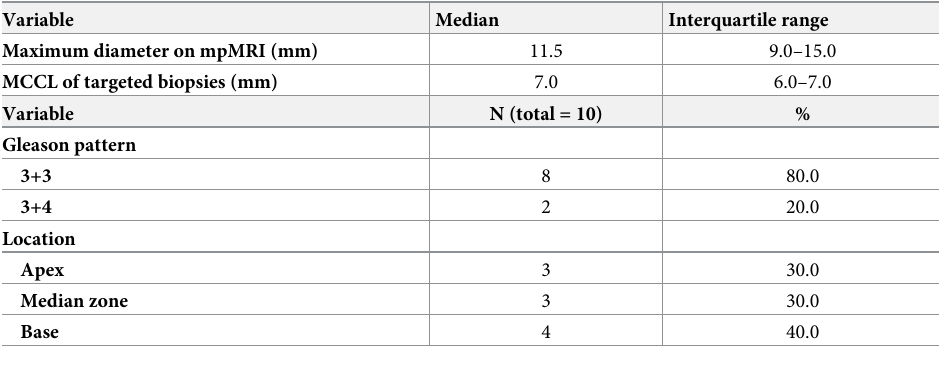
MCCL : Maximum Cancer Core Length